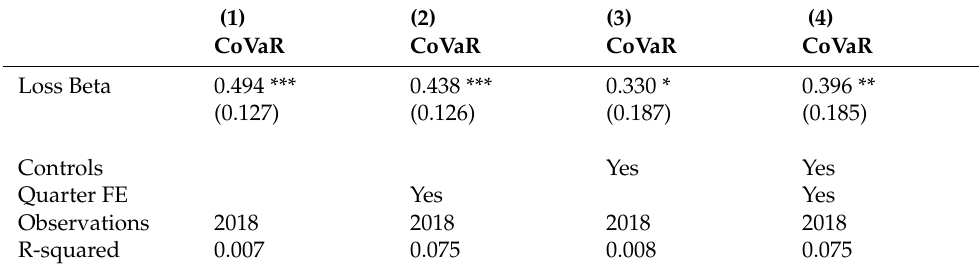
Table 5. Loss Beta and CoVaR. This table reports coefficients and standard errors of panel regressions of loss beta on CoVaR. Loss beta following the models in Section 2 using Call Reports. CoVaR is constructed following Adrian and Brunnermeier (2016). Controls include bank asset obtained from Call Report. The sample is from the first quarter of 2002 to the second quarter of 2019 with U.S.banks with assets over $50 billions. Standard errors are reported in parentheses. ***, **, and * indicate statistical significance at the 1%, 5%, and 10% levels, respectively, based on a t